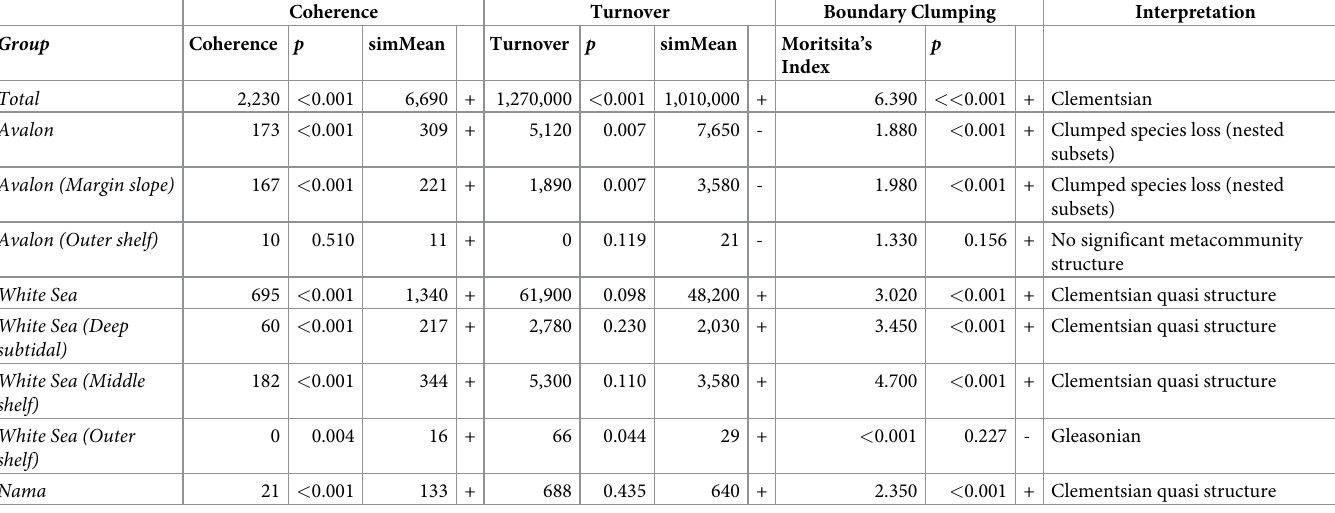
Table 1. Metacommunity analyses. Metacommunity values for coherence, turnover, and boundary clumping with interpretation of metacommunity structure within the EMS framework. Z is the Z-score, p is the p -value, and simMean is the simulated mean value of the metric.